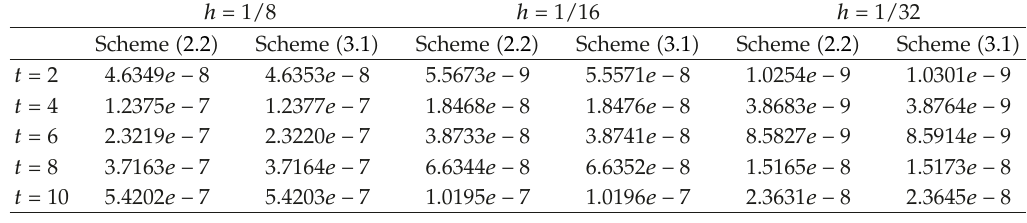
Table 3: The errors estimates in the sense of (cid:4) · (cid:4) ∞ , when p (cid:7) 8 and τ (cid:7) 0 . 1.